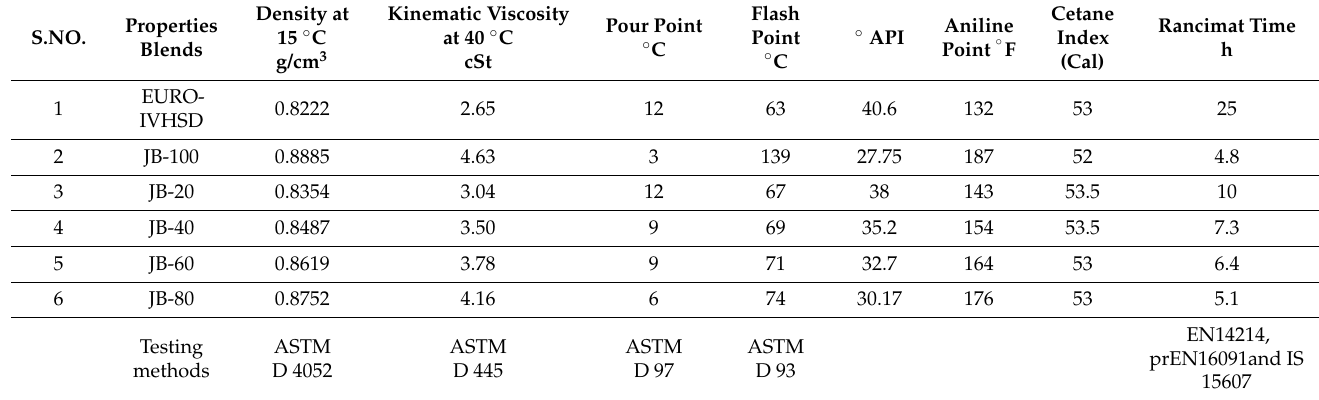
Table 6. Physical and chemical properties of Euro-IV HSD and Jatropha curcus methyl ester blends (JB+E-IV).